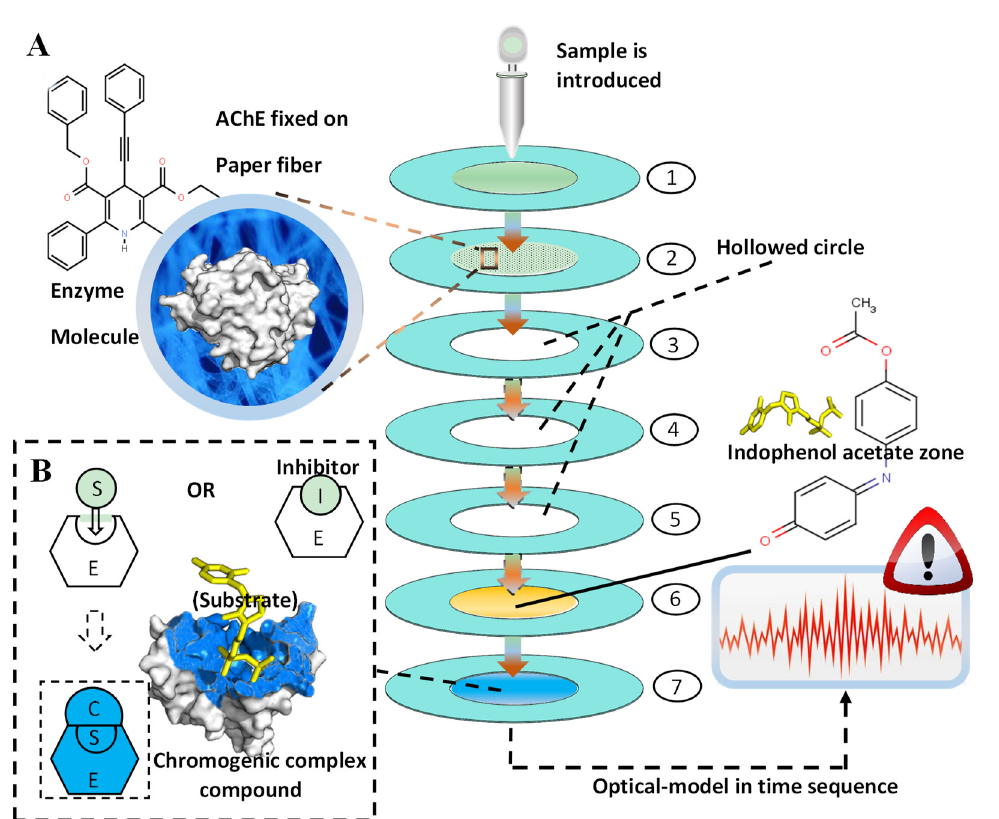
Figure 6. The schematic overview of the proposed pesticide identification platform. ( A ) The layout of the seven-layer microfluidic paper chip and the molecular structure of AChE and indophenol acetate (substrate). After the chromatic hydrolysis of indophenol acetate via the chip, the absorbance figures were processed and analyzed by intellectual devices. ( B ) The chemical reaction of enzyme inhibition on the molecular scale. With the absence of inhibitor (Organophosphate pesticides and carbamate pesticides), the S (substrate) could be catalyzed by AChE, fabricating the colored complex compound, which could be introduced to the 7th layer of the proposed chip.